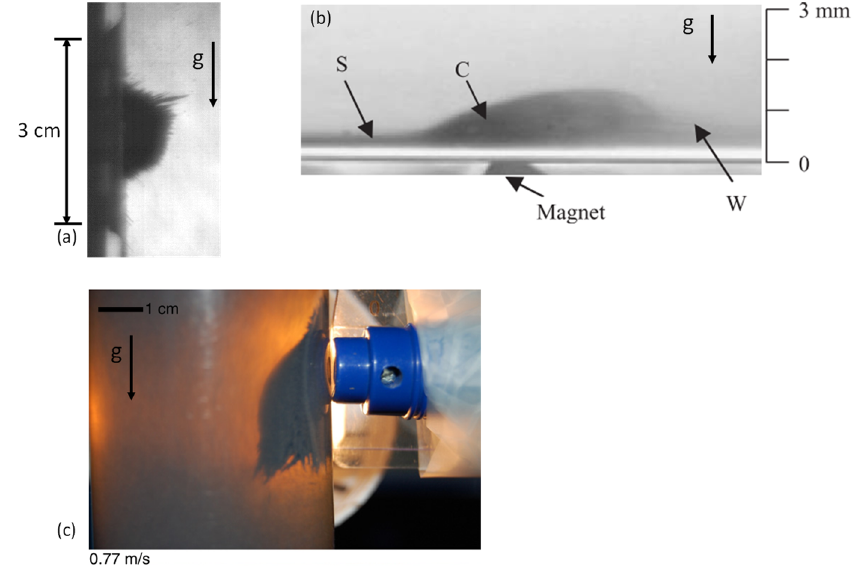
Figure 5. Observation of bulk of particles. ( a ) – Particles in the present work. ( b ) – Experiment from Reference [18]. ( c ) – Experiment from Reference [21].